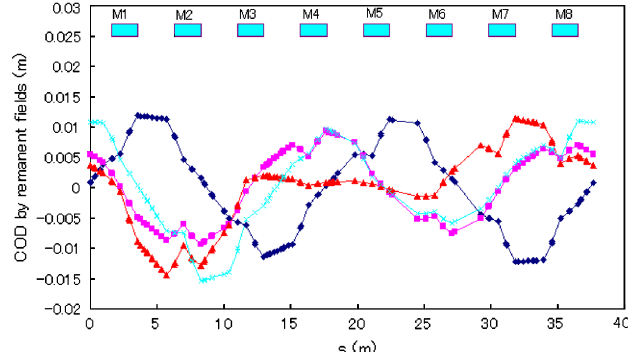
FIG. 42. CODs calculated from the remanent field. Squares at the top of the figure indicate the positions of the eight magnets. Each of the four lines corresponds to one of the cases described in Sec. VIII